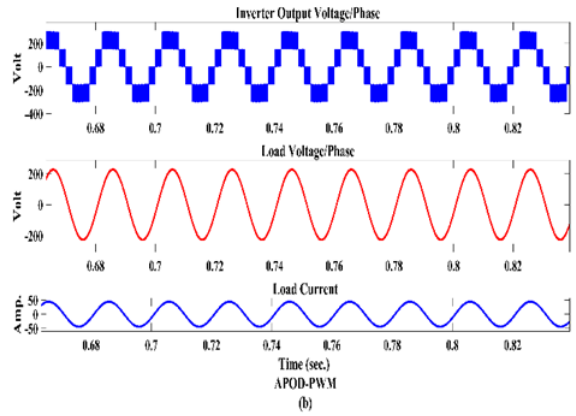
Fig.5. output load voltage and current with: (a) PD-PWM, (b) APOD-PWM Fig. 6 shows the Line-to-Line output voltage from the 5LANPC, these voltages with PD- PWM is in Fig. 6(a), while Fig. 6(b) shows the Line-to-Line output voltage with the APOD- PWM.